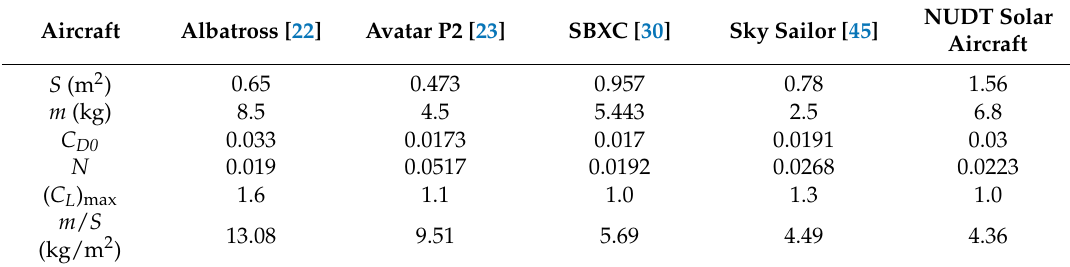
Table 2. Aircraft